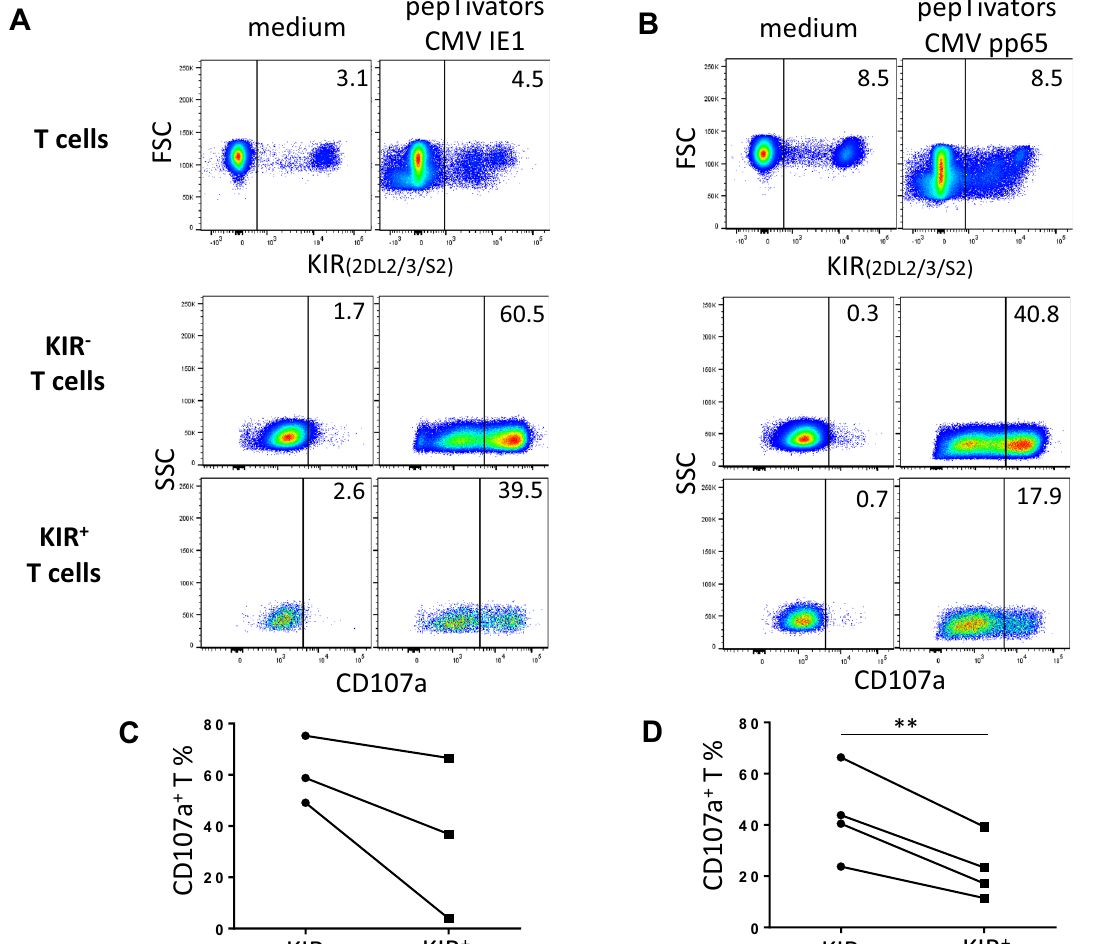
Figure 3. Lower ex vivo degranulation of CMV specific KIR + T lymphocytes compared to KIR − counterpart in HSCT recipients. Density plots illustrating the ex vivo degranulation of (A) IE1 and (B) pp65 specific KIR2DL2/3 − and KIR2DL2/3 + T lymphocytes from HSCT recipients. PBMC at day 100 post-graft were incubated with IE1 or pp65 peptivators during 6 h. T cell degranulation observed in 5 recipients against CMV with 3 specific responses against IE1 (C) and 4 specific responses against pp65 (D) . Student’s t test. **Indicates p <